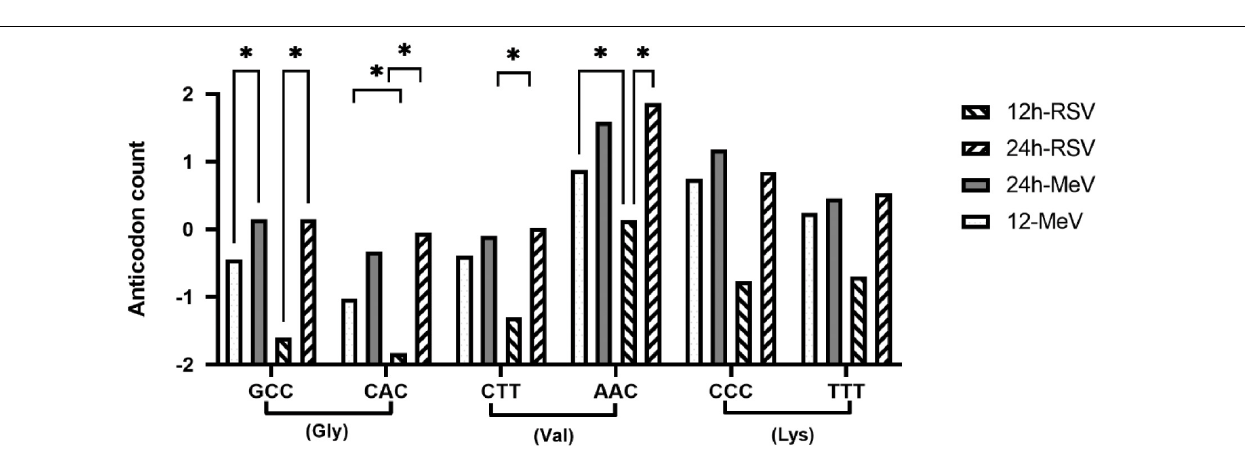
FIGURE 4 | Anti-codons for foremost 5 (cid:48) tRFs during RSV- and MeV-infection. Anti-codon sequence for the top 5 (cid:48) tRFs deregulated in mock, RSV-, or MeV-infected SHS cells. Error bars represent ± SD from three replicate data. Comparisons were done using 2-way ANOVA with a mixed model (to account for outliers) and two replicates for mock followed by post hoc Tukey’s correction for multiple comparisons. ∗ Indicate comparisons with significance p ≤ 0.05. Triplets on the x-axis indicate codon